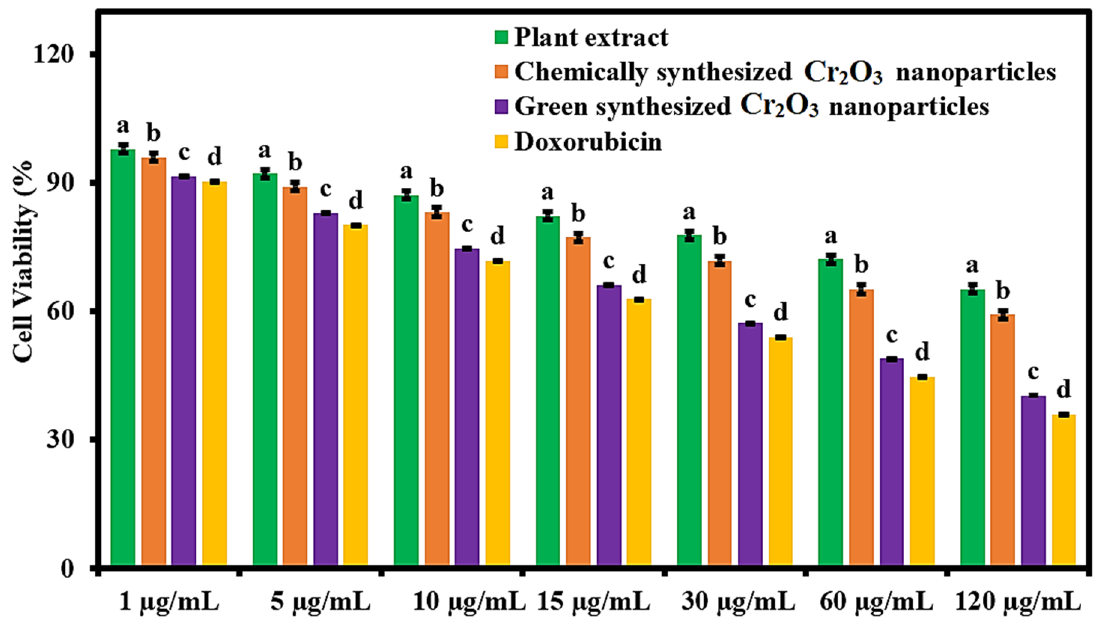
Figure 6. Anticancer activity of green synthesized Cr 2 O 3 nanoparticles in terms of cell viability percentage against MCF-7 cancer cells compared to Abutilon indicum (L.) Sweet leaf extract, chemically synthesized Cr 2 O 3 nanoparticles, and standard drug. (Note: Tukey based heterogeneous lower-case letters represent significant pairs).